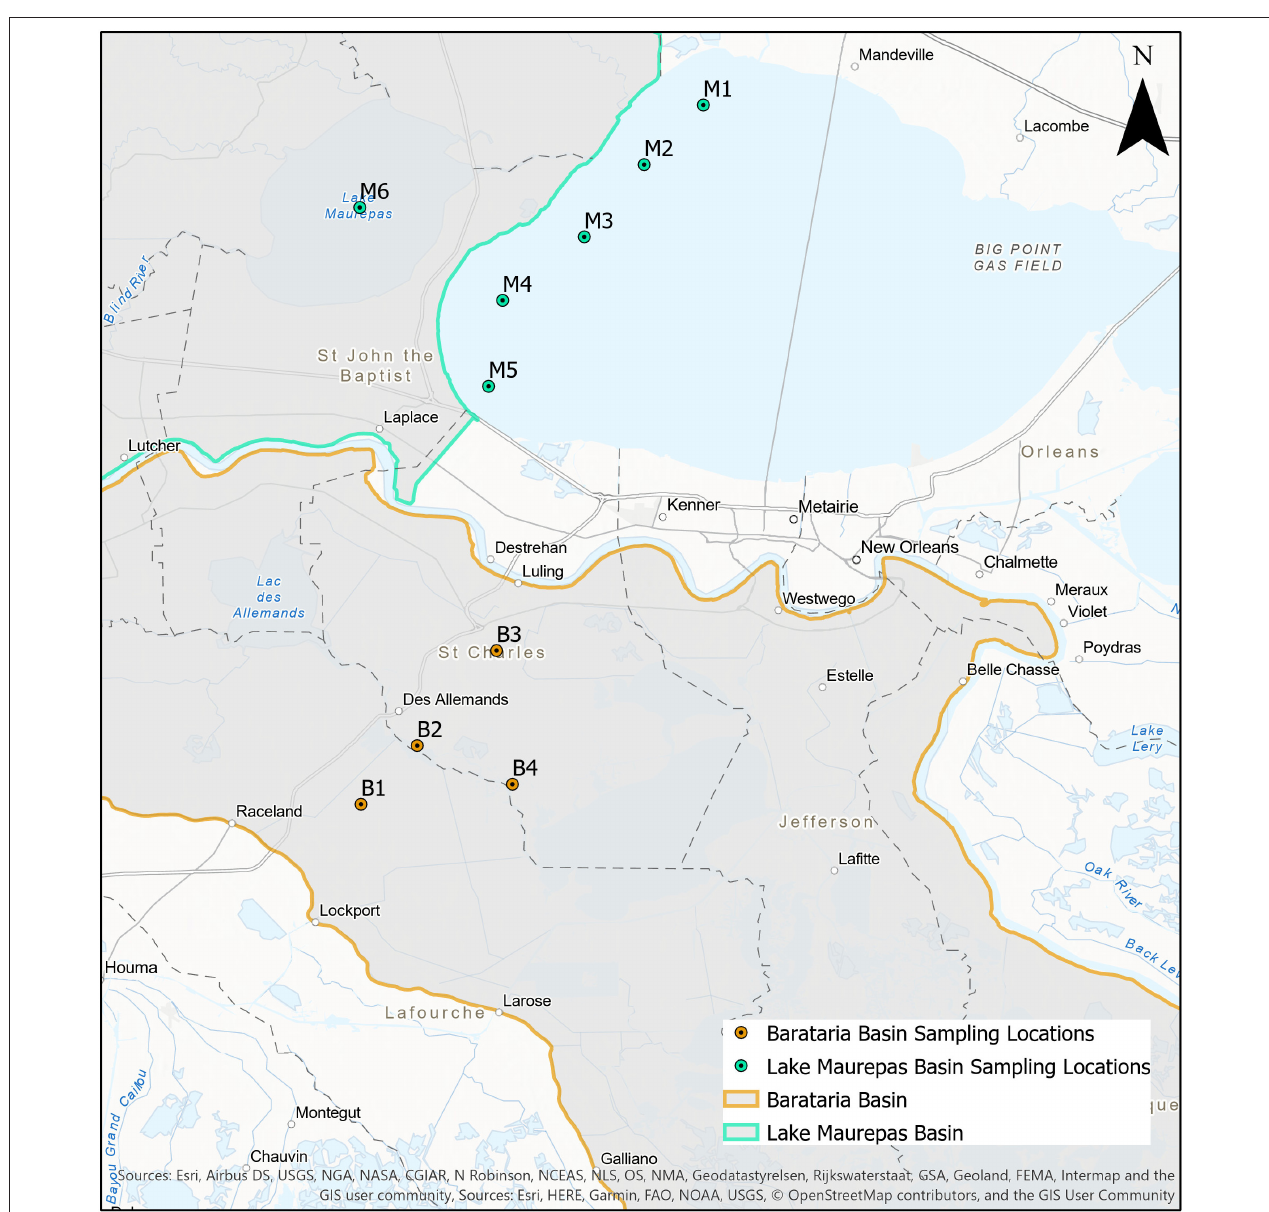
FIGURE 2 | Sampling locations for the synthetic storm selection in the Barataria watershed (B, orange circles) and Lake Maurepas (M, green circle)